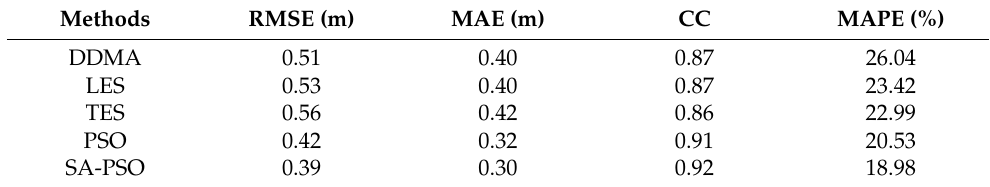
Table 1. RMSE, MAE, CC, and MAPE statistics of swell height results retrieved by five schemes.